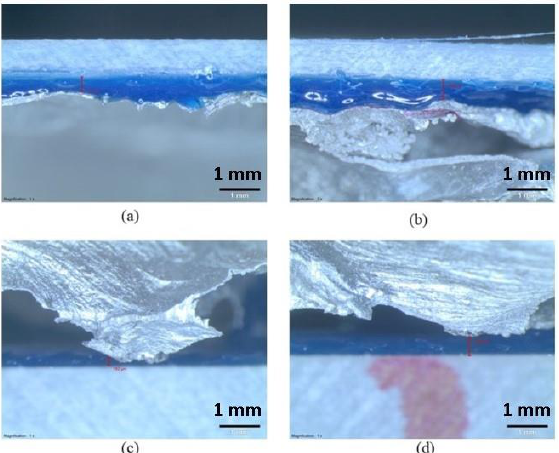
Figure 8. Low-density foam core (LDFC) face sheet/core interface: ( a ) and ( b ) show the top face sheet/core interface at two different locations; ( c ) and ( d ) show the bottom face sheet/core interface at two different locations.